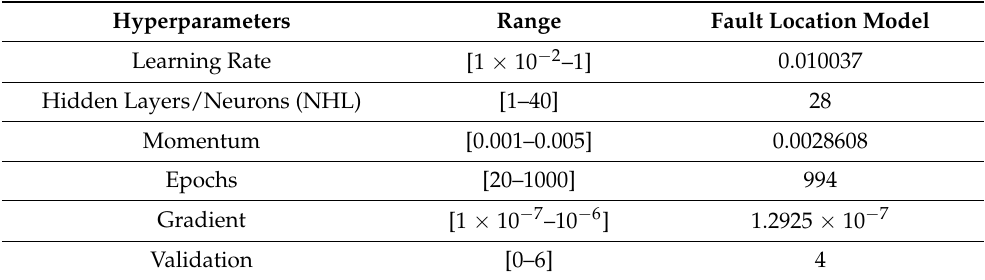
Table 6. Optimized Table 6. Optimized parameters .